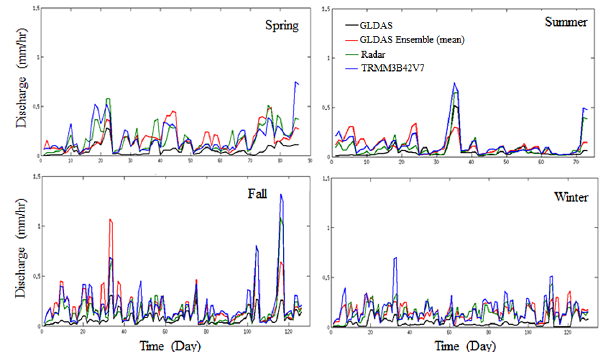
Figure 10. Runoff time series driven by the different precipitation products over the basin indicated in Fig. 1 and consisting of the selected validation events of each season. GLDAS shows underes- timation in all cases; meaningful improvement is shown in down- scaled error-corrected